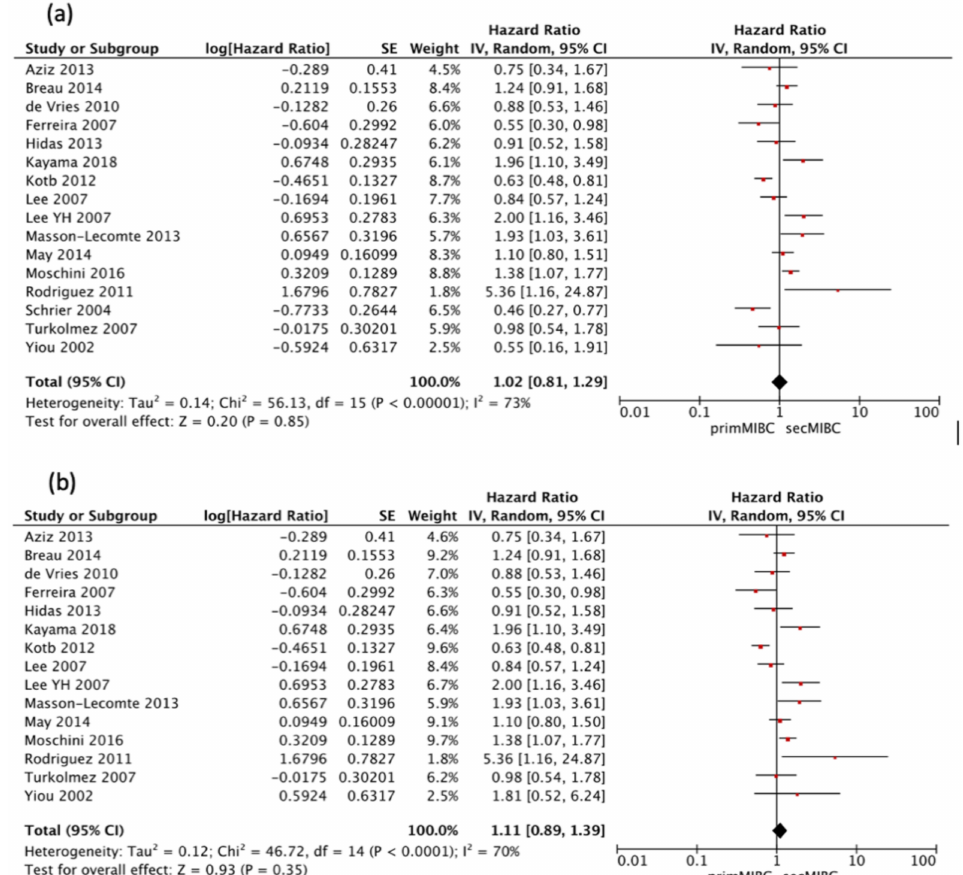
Figure 3. ( a ) Forest Plot for 5-year CSS according to starting point of follow-up, ( b ) Forest Plot for 5-year CSS after